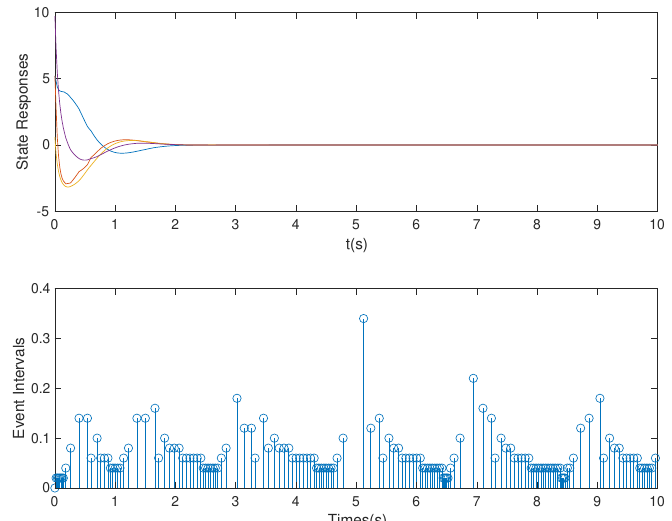
Figure 9. State responses and event intervals with DoS attacks ( p = 1.5 s) for OB-ETPC.